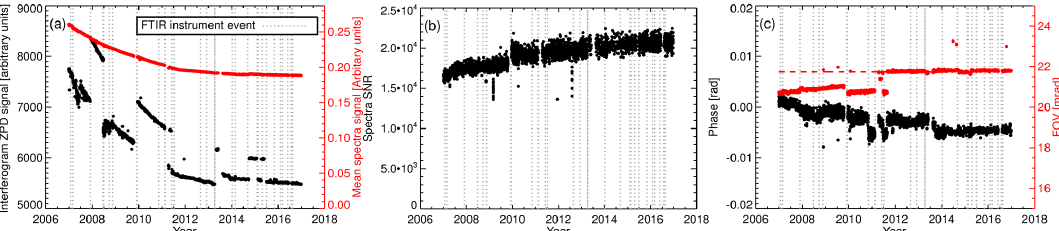
Figure 5. (a) Bruker IRcube interferogram ZPD signal and the mean signal level of the associated spectra calculated over the range 2450– 2550cm − 1 . (b) Spectra SNR over the range 2450–2550cm − 1 . The 2450–2550cm − 1 region was selected due to a lack of absorption features and is representative of the spectrum continuum level. (c) Fitted spectra phase and